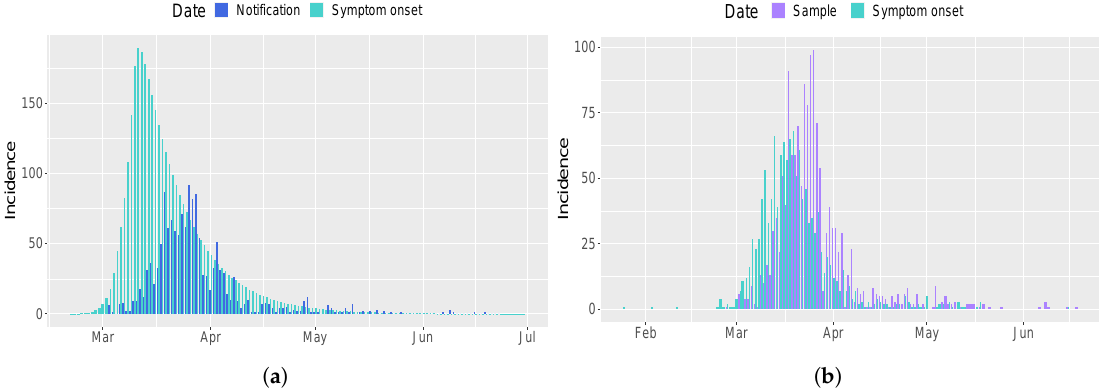
Figure 4. Comparison of new positives cases for Umbria region. ( a ) Epidemic curve estimated by the model (light blue) in comparison with the observed data of the Italian Civil Protection Department (blue) [21]. ( b ) Epidemic curve based on date of sample (violet) and symptom onset (light blue) estimated by the Italian National Institute of